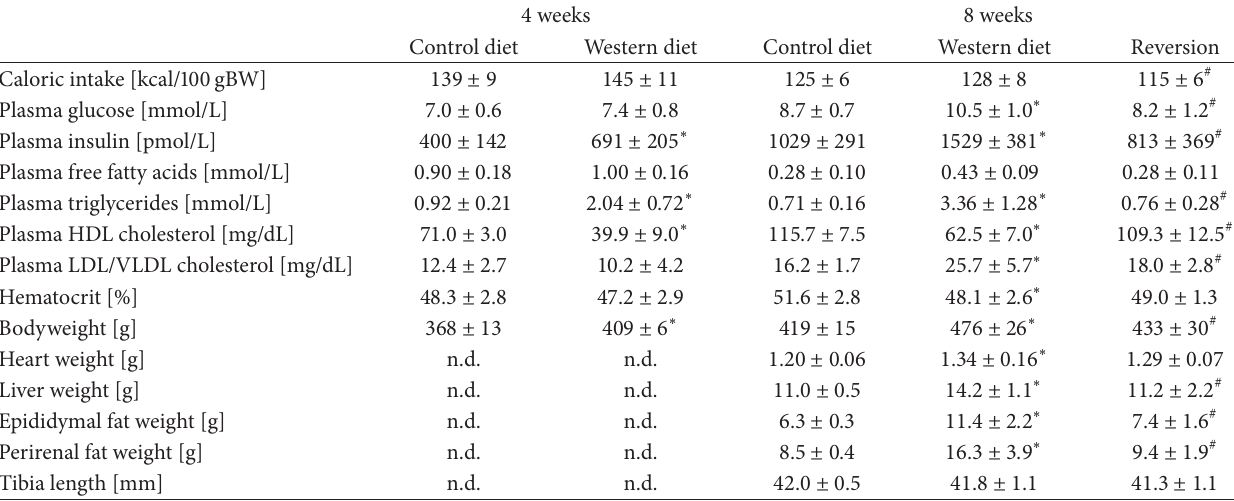
Table 1: Characteristics after 4 and 8 weeks of diet intervention without sevoflurane exposure.